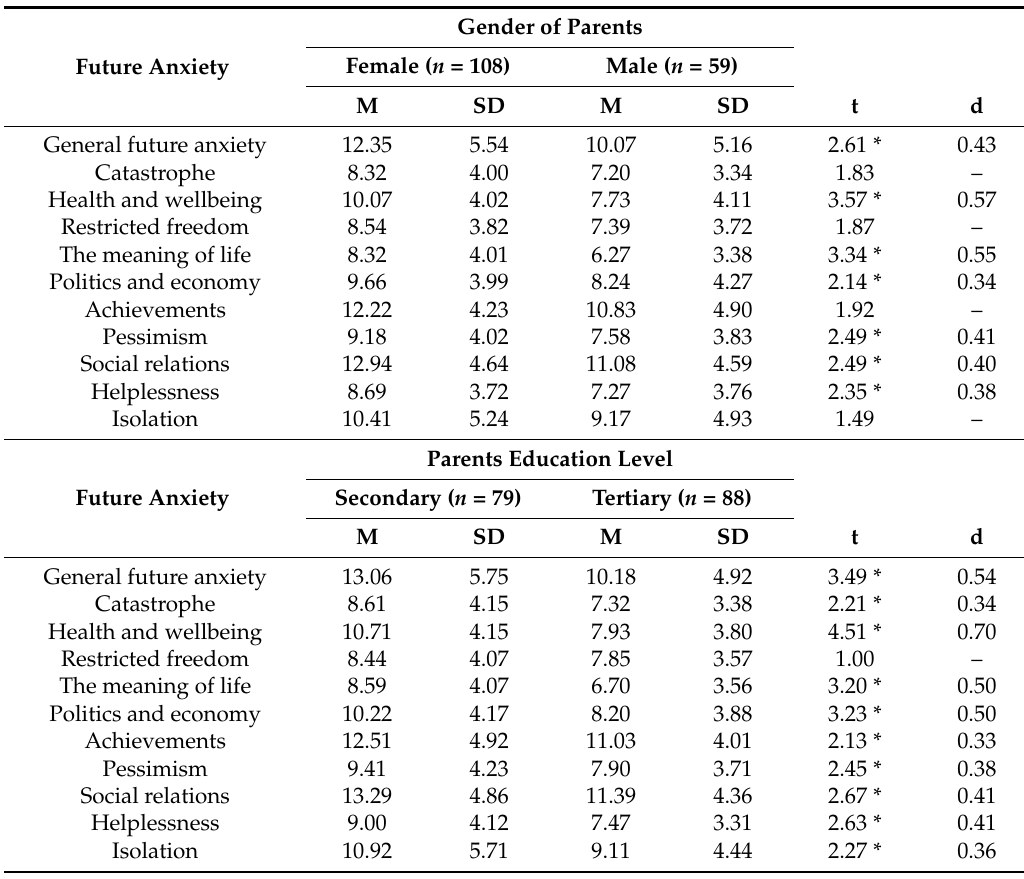
Table 3. Means, standard deviations, t -statistics (df = 165), and effect size (Cohen’s d) for demographic variables and future anxiety for the families with a child with